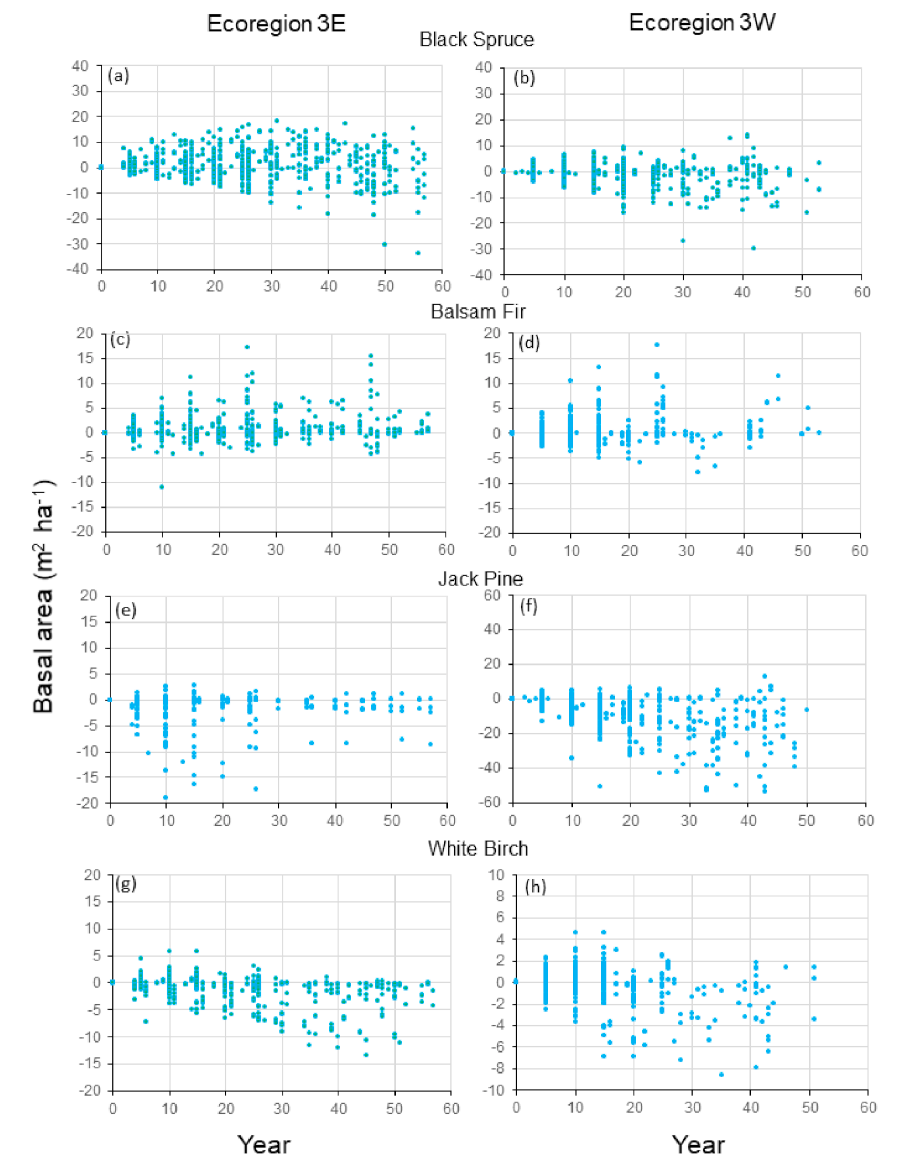
Figure 3. Graphs of differences between observed and predicted basal areas for black spruce ( a , b ), balsam fir ( c , d ), Jack pine ( e , f ) and white birch ( g , h ) over years in ecoregions 3E and 3W of the boreal forest region of northern Ontario,